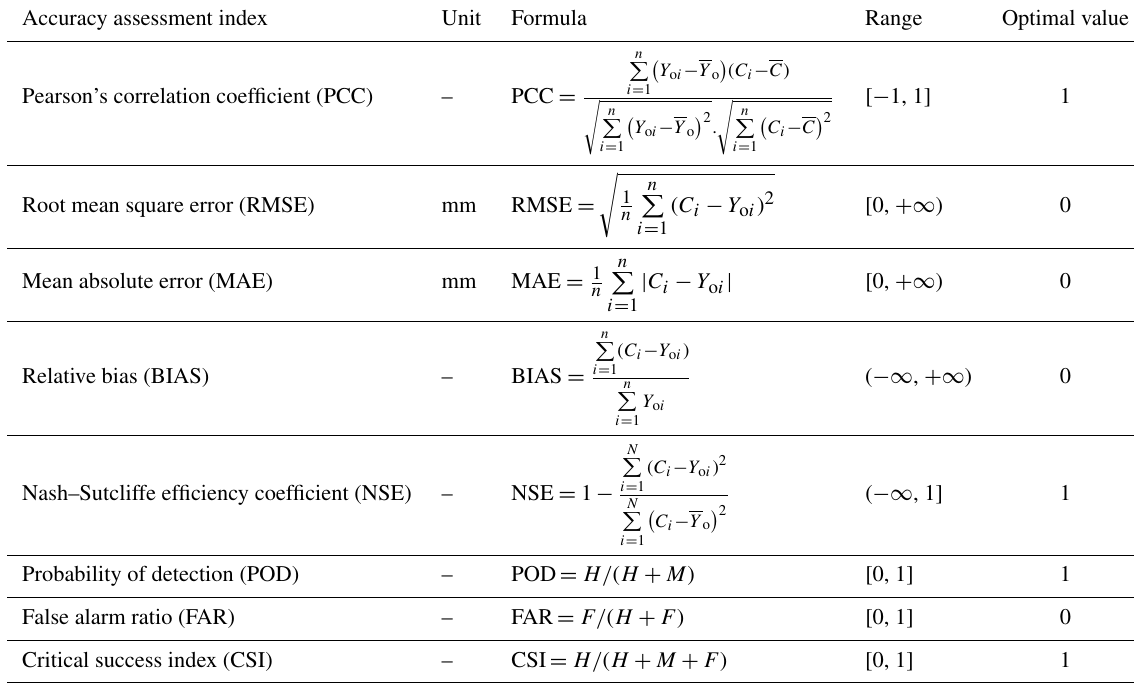
Table 2. Accuracy assessment